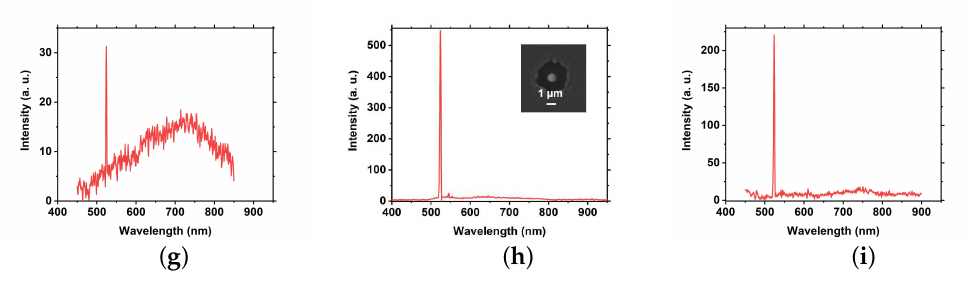
Figure 4. PL measurements of single hybrid NP obtained from bi-layer Au/Si films with different thickness (( a , d ) 10/100 nm, ( b , e ) 30/180 nm and ( c , f ) 30/90 nm: ( a – c ) PL spectra; ( d – f ) dependencies of broadband PL intensity on pump fluence; PL spectra of initial bi-layer Au/Si (30/180 nm) film ( g ), single gold ( h ) and silicon ( i ) NPs. Insets show corresponding SEM images of single